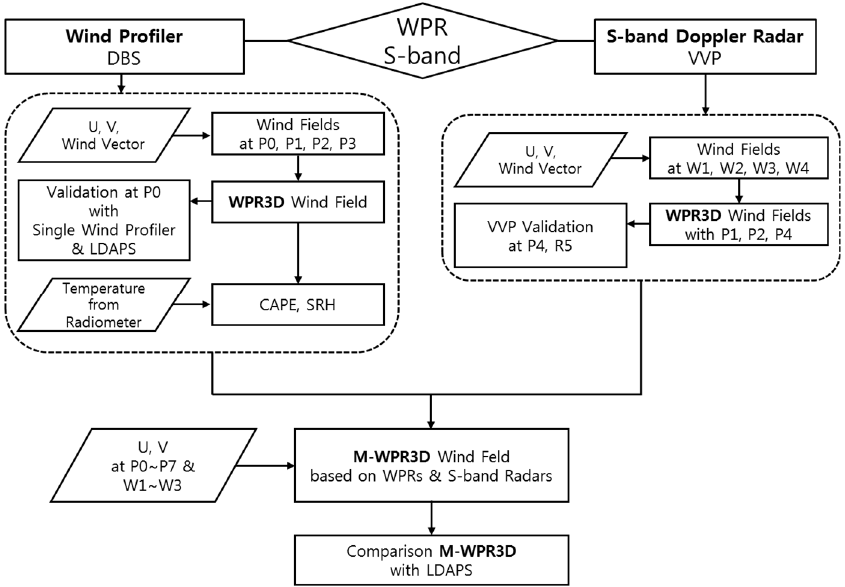
Figure 1. Scheme of the research to construct the three-dimensional wind field (WPR3D) and the multiple WPR3D (M-WPR3D) wind field. Observational sites of 8 wind profilers and 4 S-band radars are indicated by P0–P7 and W1–W4, respectively. R5 is the WPR3D reference point of the triangle P1– P2–P4.